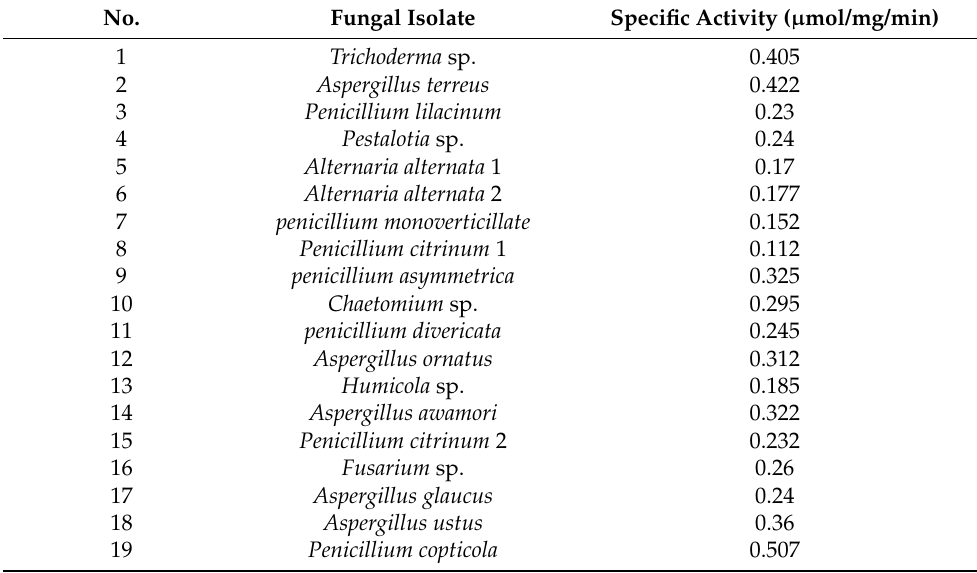
Table 1. Screening for tyrosinase production by endophytic fungi of Moringa oleifera. No. Fungal Isolate Specific Activity ( µ mol/mg/min) Trichoderma sp.